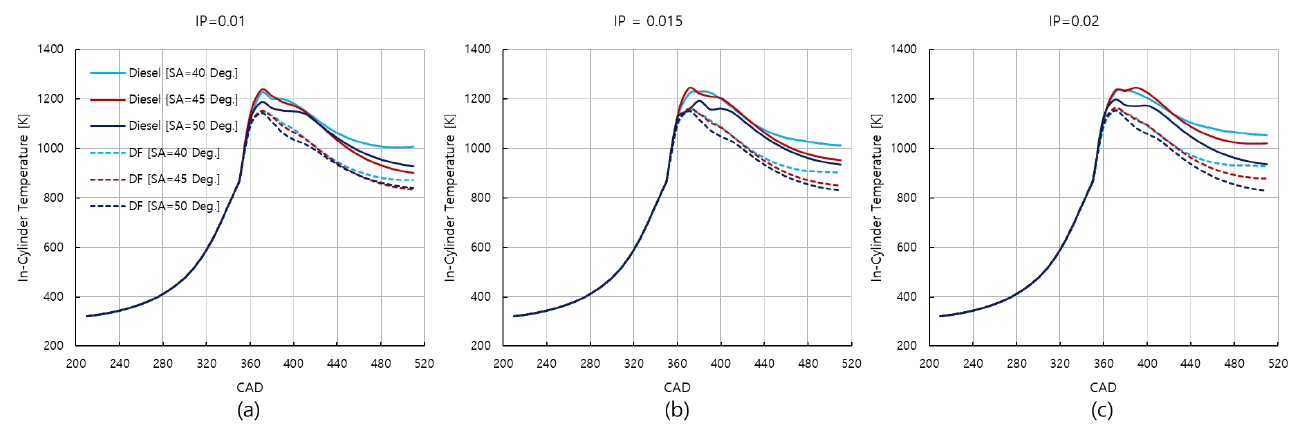
Figure 12. In-cylinder average temperature diagrams in all simulation cases: ( a ) IP = 0.01 m; ( b ) IP = 0.015 m; ( c ) IP = 0.02 m.